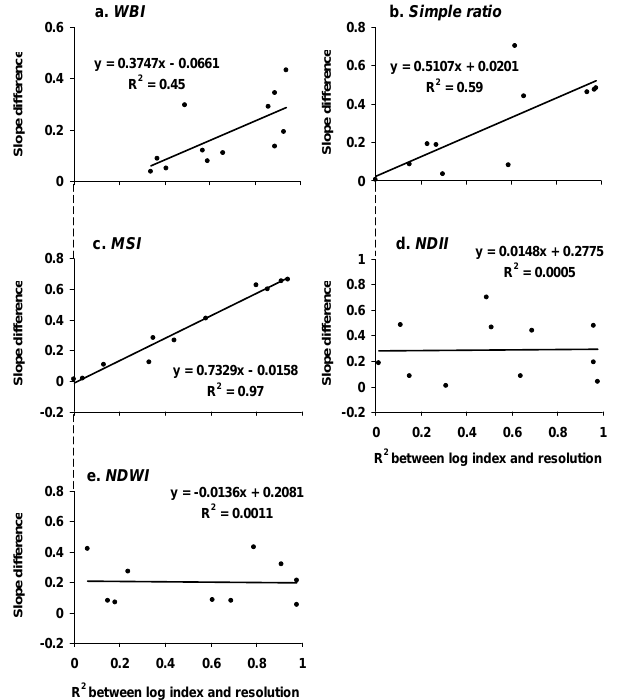
Fig. 8 – The absolute difference between the slopes obtained by the wavelengths of the Fig. 8. The absolute difference between the slopes obtained by the indices WBI (water band index), Simple ratio , MSI (moisture stress index), NDII (normalized wavelengths of the indices WBI (water band index), Simple ratio, difference infrared index), and NDWI (normalized difference water index), are plotted against the R 2 between the log of these indices and the log of the spatial resolution. These slopes are MSI (moisture stress index), NDII (normalized difference infrared between the log reflectance and log spatial resolution obtained at the 920 nm and 960-1000 nm index), and NDWI (normalized difference water index), are plot- range for the WBI , 820 nm and 1600 nm for the Simple ratio, 1550-1750 nm and 760-800 nm ted against the R 2 between the log of these indices and the log of range for the MSI , 820 nm and 1600 nm for the NDII , and 860 nm and 1240 nm for the NDWI (n = the spatial resolution. These slopes are between the log reflectance 11, significance value < 0.05, critical value R 2 > 0.28). and log spatial resolution obtained at the 920nm and 960–1000nm range for the WBI, 820nm and 1600nm for the Simple ratio, 1550– 1750nm and 760–800nm range for the MSI, 820nm and 1600nm for the NDII, and 860nm and 1240nm for the NDWI ( n = 11, sig- nificance value < 0 . 05, critical value R 2 > 0 . 28).